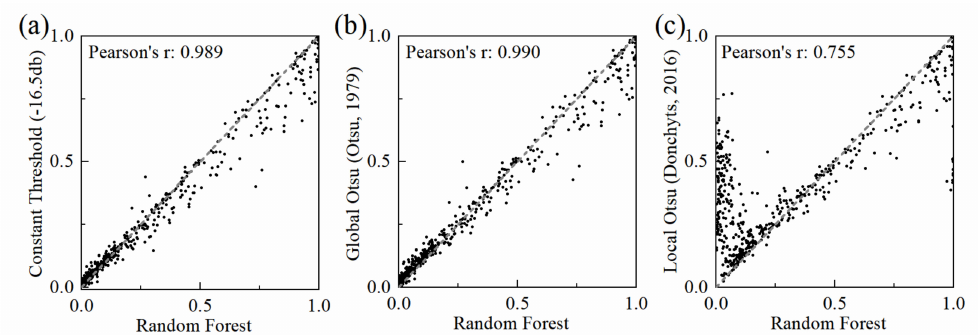
Figure 6. The relationships between reference water ratios in grids of 0.05 × 0.05 degrees derived from Random Forest algorithm using Sentinel-2 imagery and classified water ratios derived from ( a ) constant threshold of − 16.5 dB, ( b ) the Global Otsu Algorithm [57], and ( c ) the adaptive local threshold method [58] using Sentinel-1 imagery. Grey dashed lines are the 1:1